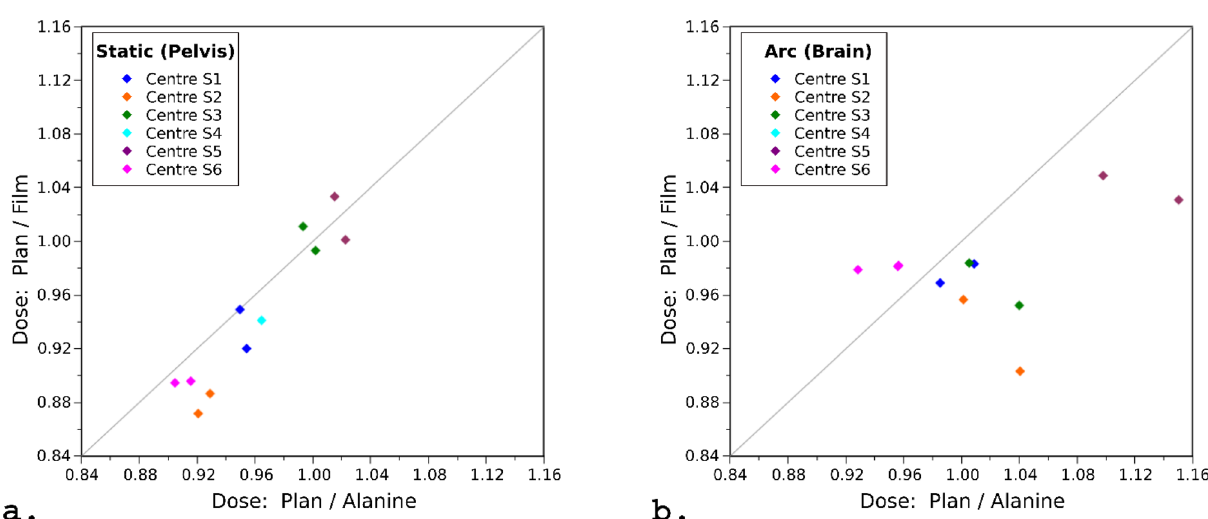
Figure 8. Comparison of the absolute dose measurements acquired using alanine pellets and Gafchromic EBT3 film for ( a ) the static 10 × 10 mm fields and ( b ) the arc deliveries. Results are presented in terms of the ratio of the planned dose to the measured dose (i.e. TPS/Film and TPS/Alanine). A ratio > 1 indicates that the planned dose was greater than the measured dose. The diagonal line indicates the line of agreement between the alanine and film